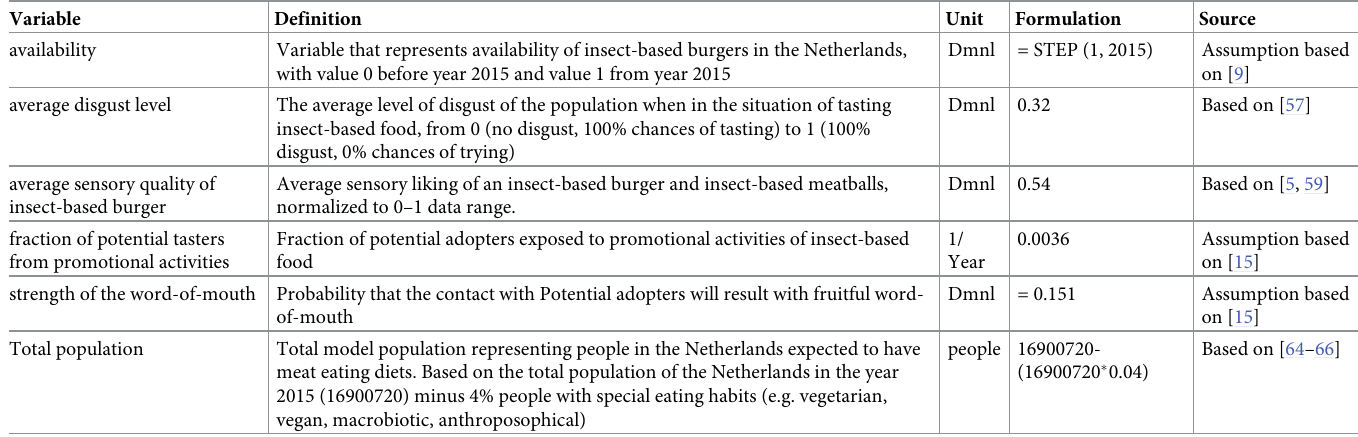
Table 2. Constant variables of the insect-based food adoption model, with values used for the base run.